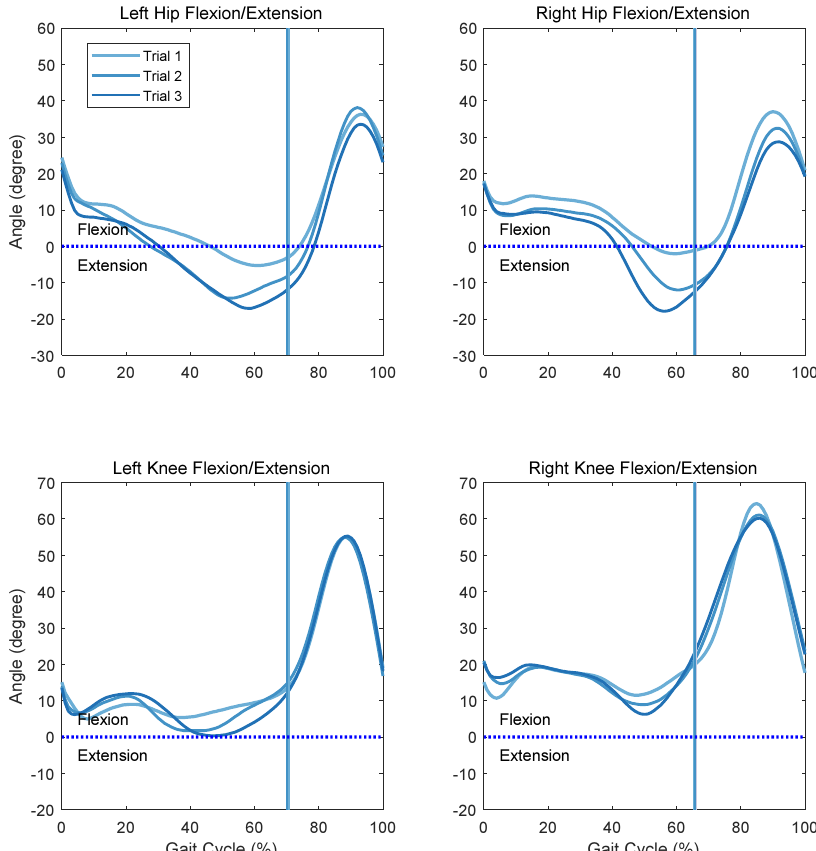
Figure 19. Kinematic results of walking trials with the three different right knee assistive